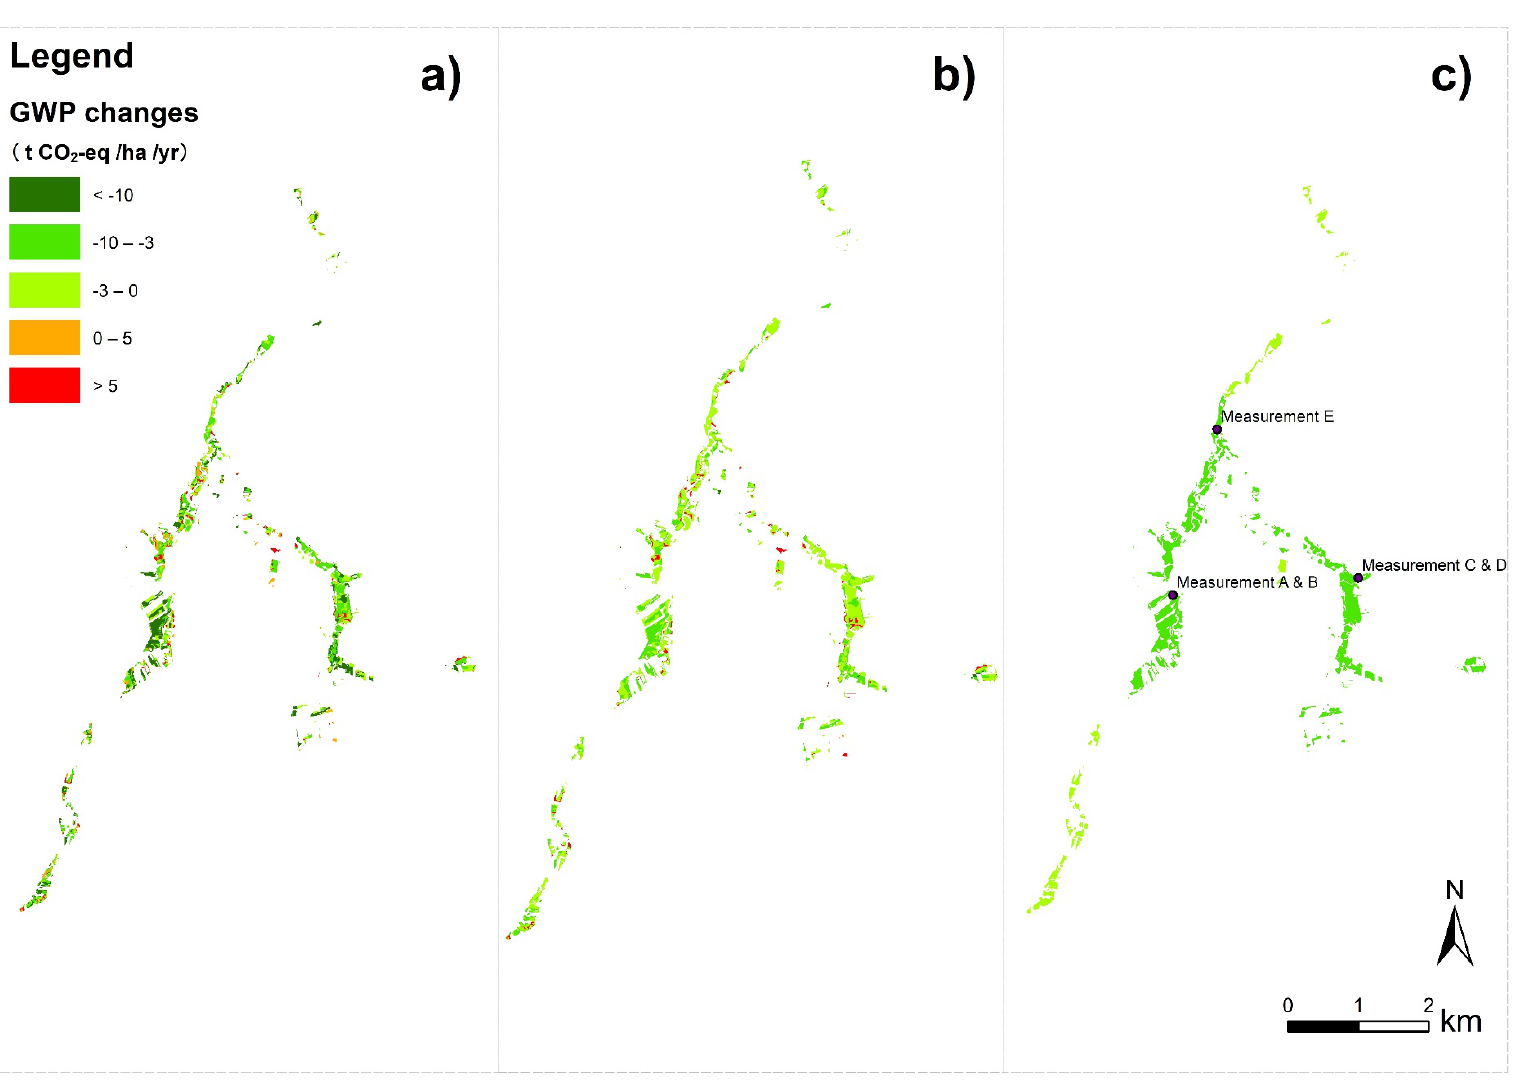
Figure 3. Comparison of GWP reduction from 3 approaches at rewetted areas in the middle reaches of the Drentsche Aa: a) the vegetation - water level proxy approach; b) the IPCC emission factors approach; c) the measurement-based approach. Points represent locations of measurement wells